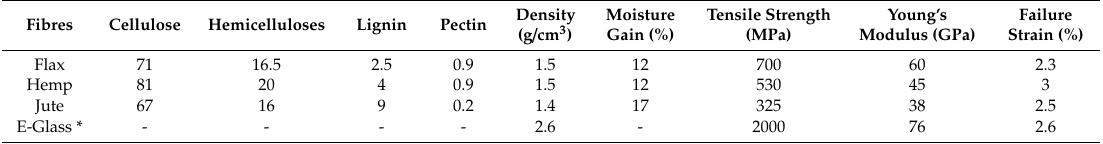
Table 5. Chemical composition, physical and mechanical properties of commonly used natural bast fibres